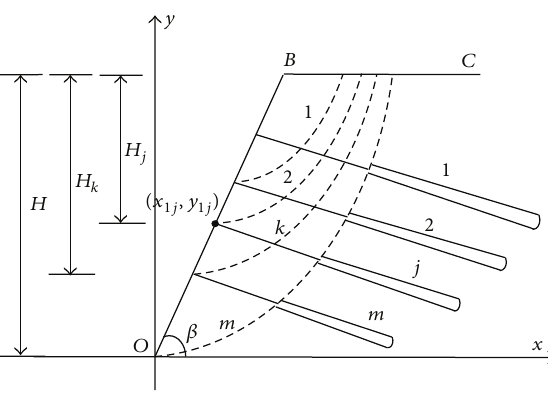
Figure 4: Anchor arrangement and slope excavation